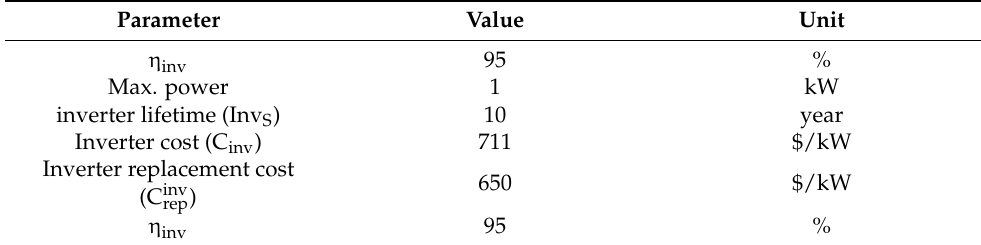
Table 5. The main parameters characteristics of the inverter.